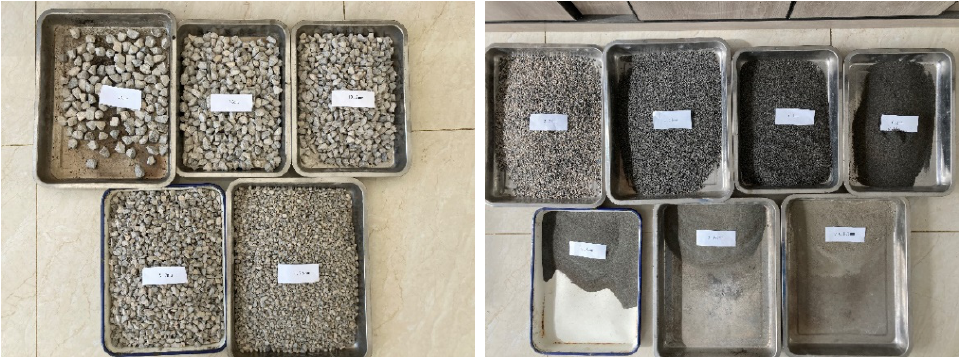
Figure 2. Crushed stone samples with different particle sizes before blending. Table 2. Initial gradation of samples before repeated compaction